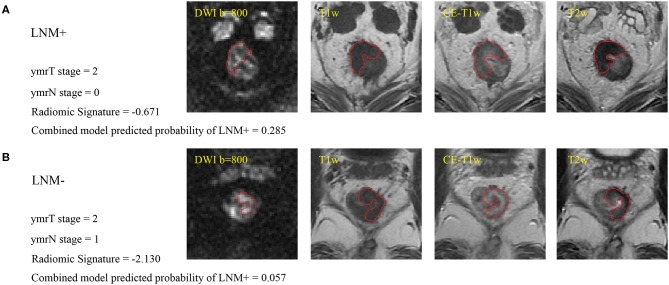
(A) Sample images of LNM+, where the red line indicates the tumor margin. (B) Sample images of LNM–. Cutoffs for the radiomic signature and combined model are −1.4208 and 0.0897, respectively, for patients with ymrT1-2 tumors in this study. These two patients were misdiagnosed by the radiologist but were correctly assessed by radiomics analysis. LNM+, lymph node metastasis; LNM–, lymph node non-metastasis; DWI, diffusion-weighted imaging; T1w, T1-weighted; CE-T1w, contrast-enhanced T1-weighted; T2w, T2-weighted.